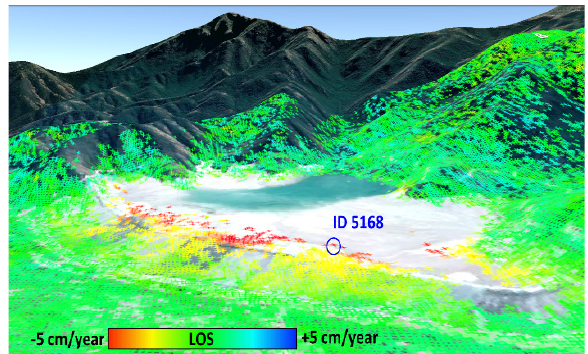
Figure 3. SBAS deformation map produced from Sentinel-1 images taken in 2017. Positive and negative LOS velocities imply rising and sinking movements, respectively. Point ID 5168 used for further discussion. Background, Google Earth image.